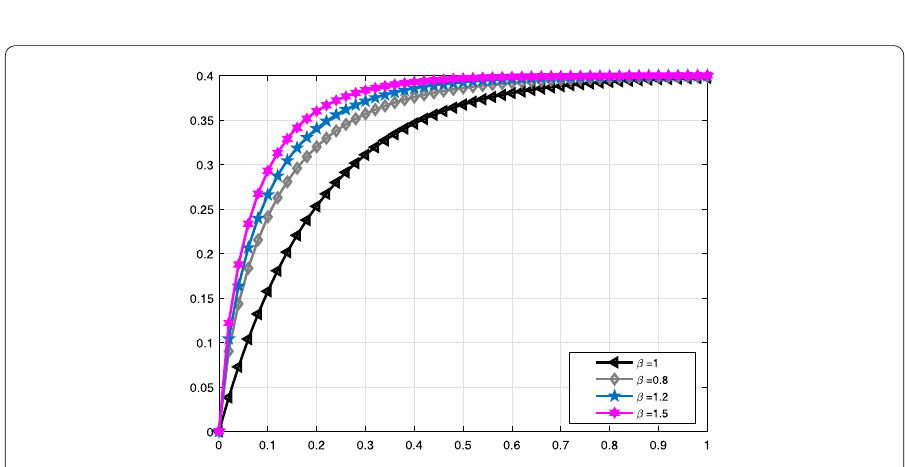
Figure 2 Comparative analysis with truncated M -derivative for V i ( t ), α =